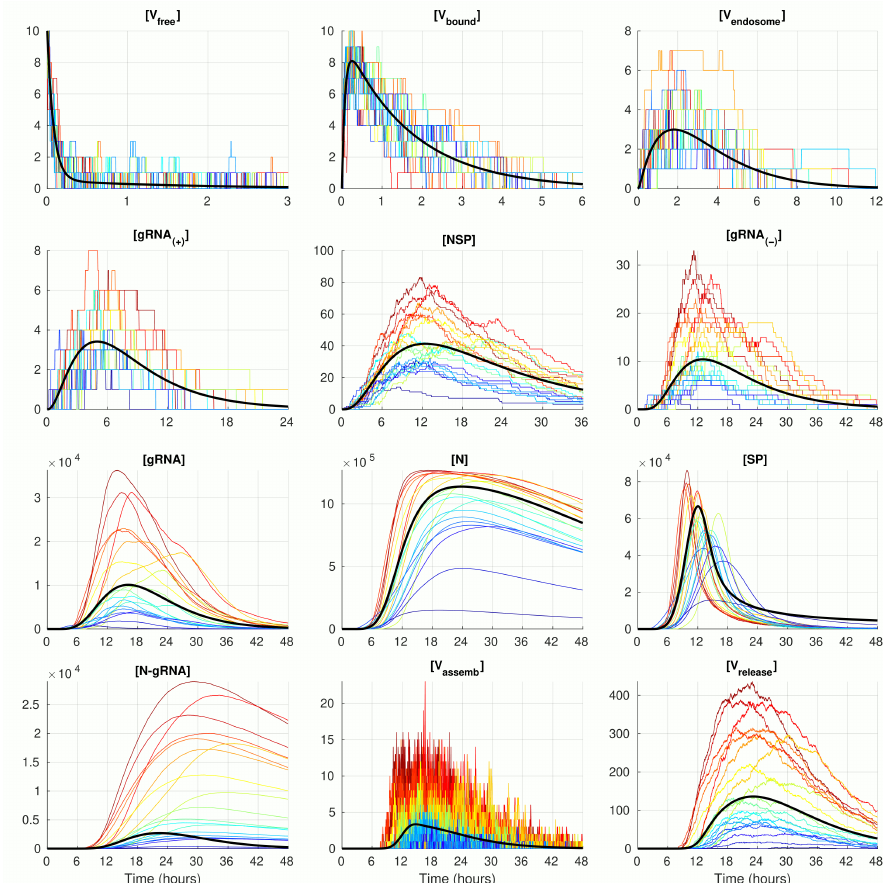
Figure 2. Examples of stochastic realisations for [ V free ]( 0 ) = 10. The black curves indicate the solution of the deterministic